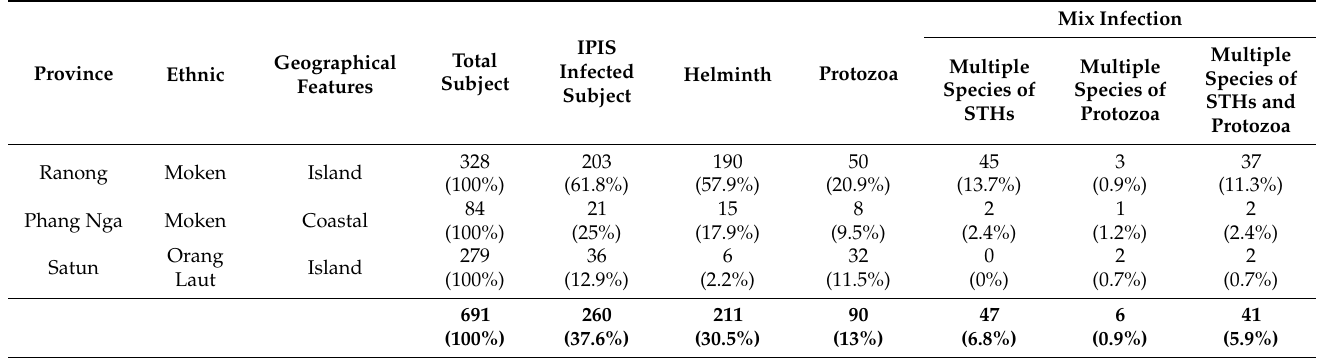
Table 1. Prevalence of IPIs in Moken and Orang Laut living in three provinces in Thailand with single and multiple infection.